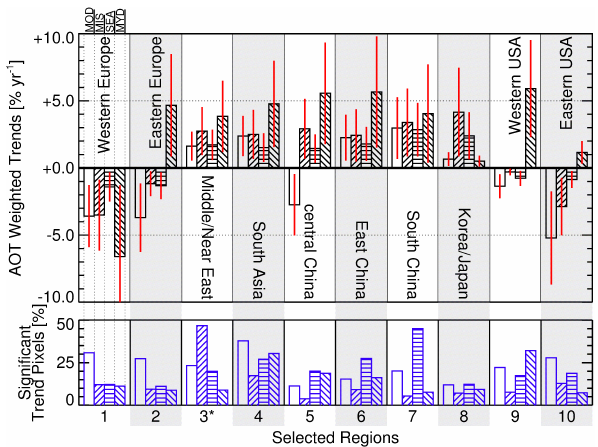
Figure 11. The relative regional trends and standard deviations ( ± 2 σ) of the four AOT data products, retrieved from the measure- ments made by MODIS-Terra (MOD) from March 2001 to Decem- ber 2009, MISR-Terra (MIS) from March 2001 to December 2010, SeaWiFS-OrbView-2 (SEA) from January 1998 to December 2007, and MODIS-Aqua (MYD) from January 2003 to December 2008, for the regions defined in Figs. 1, 9, and 10. The regional trends are the mean of the weighted trends that are significant within a 95% confidence level. The blue bar chart below shows the percentage of pixels showing a significant trend for the selected regions. For region 3 (Middle/Near East), only MISR AOTs are available over both land and ocean as a result of the bright surface saturating the measurements made by the other instruments.